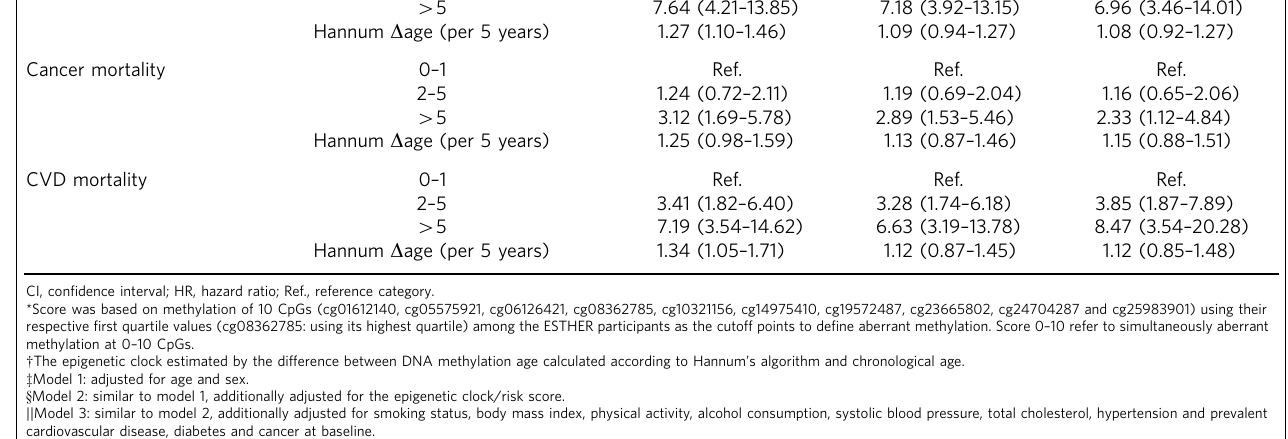
Supplementary Fig. 1. Associations of risk factors with mortality-related CpGs . To explore risk factors